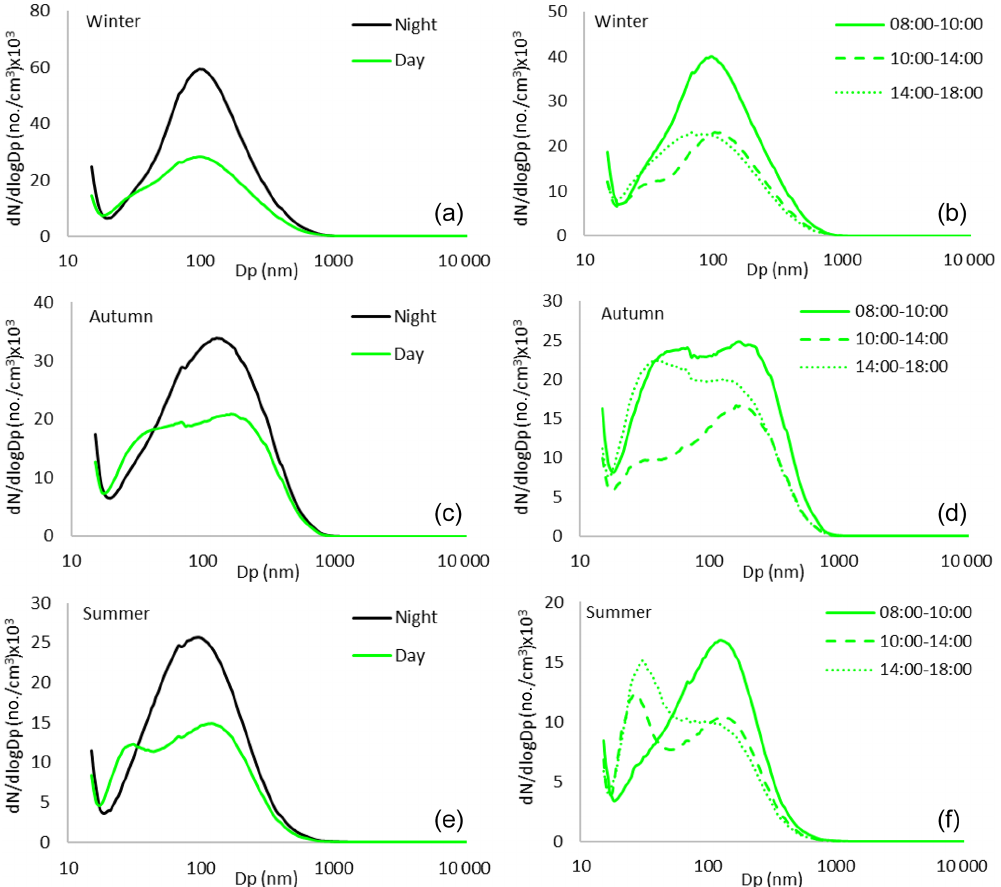
Figure 7. Hourly average particle number distributions in autumn, summer, and winter in Delhi for the day- and nighttime (a, c, e) and during daytime hours (b, d, f) .